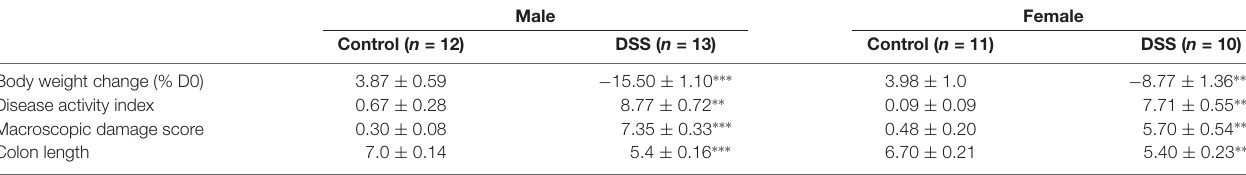
TABLE 2 | Characterization of dextran sulfate sodium (DSS)-induced colitis in male and female